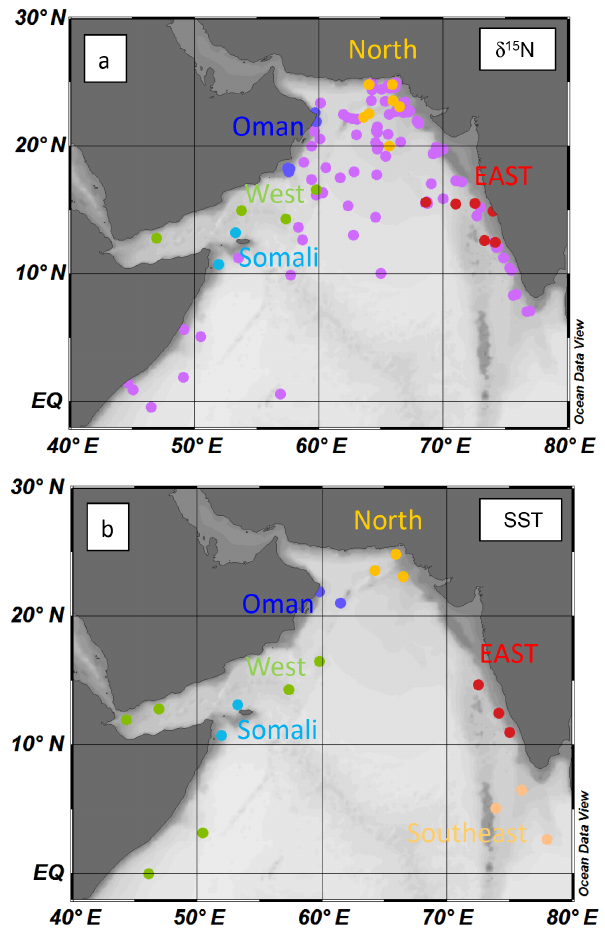
Figure 1. Stations of sediment cores for δ 15 N (a) and for SST (b) reconstructions with colors indicating surface sediment samples (purple) and cores from the Oman upwelling (dark blue), Somali upwelling (light blue), and the western (green), northern (yellow), eastern (red), and southeastern (orange) Arabian Sea.